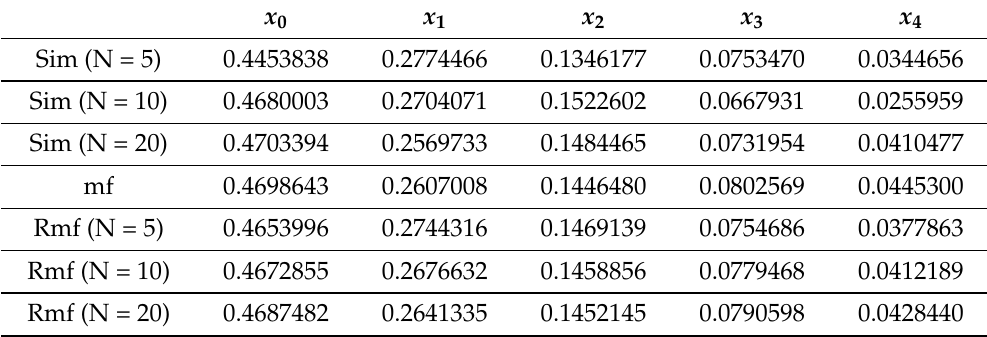
Table 1. Accuracy of mean-field approximation (mf) and refined mean-field approximation (rmf) when N =